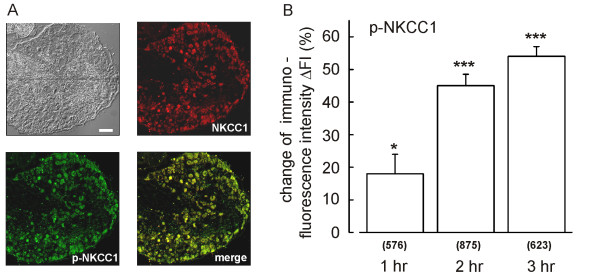
Immunohistochemical analysis of NKCC1 phosphorylation. (A) A cryosection of a T9 DRG was co-stained with antisera raised against NKCC1 and p-NKCC1 after a 3-hr treatment with inflammatory mediators. The two antibodies showed an almost perfect co-staining. The calibration bar indicates 100 μm. (B) In contrast to the NKCC1 immunosignal, the p-NKCC1 signal increased already 1 hr after the start of the treatment. The change of p-NKCC1 immune fluorescence in treated DRGs (FItest) compared to the respective contralateral control DRGs (FIctr) is expressed as ΔFI = (FItest-FIctr)/FIctr·100 [%]. ΔFI (± SD; 3 animals) was 18 ± 5.9% (1 hr), 45 ± 3.5% (2 hr), and 54 ± 3.3% (3 hr). Indicated significance levels are p ≤ 0.05 (*) and p ≤ 0.001 (***). Numbers in parentheses indicate cells evaluated.